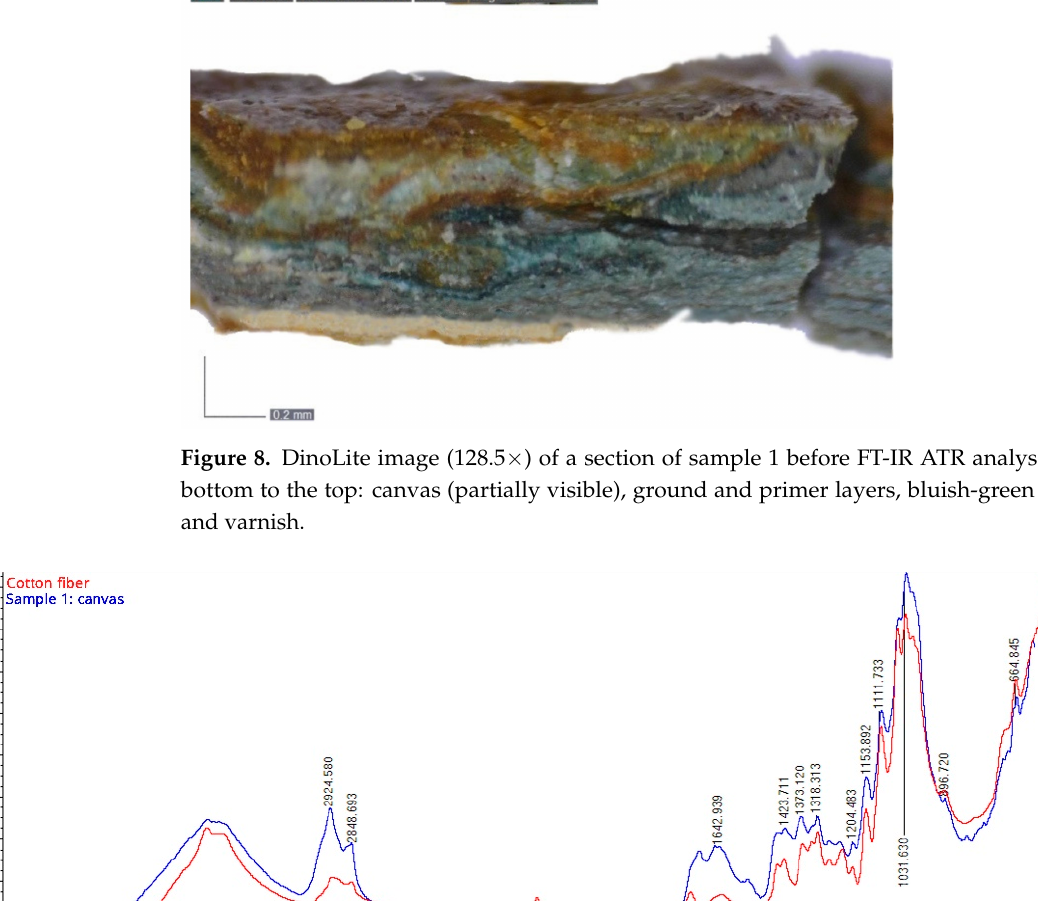
Figure 8. DinoLite image (128.5×) of a section of sample 1 before FT-IR ATR analysis. From the bottom to the top: canvas (partially visible), ground and primer layers, bluish-green paint layers, and varnish.